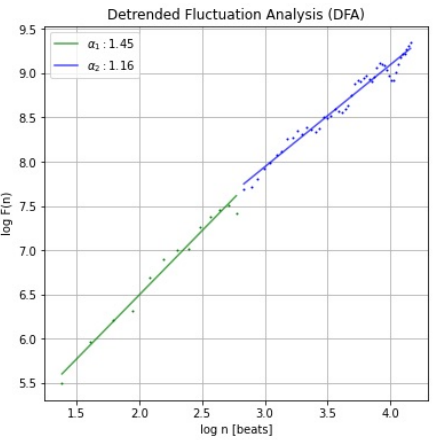
Figure 4. Detrended Fluctuation Analysis (DFA) of RR time series from a healthy subject (the same as shown in Figure 1, for more details see Appendix A.4).